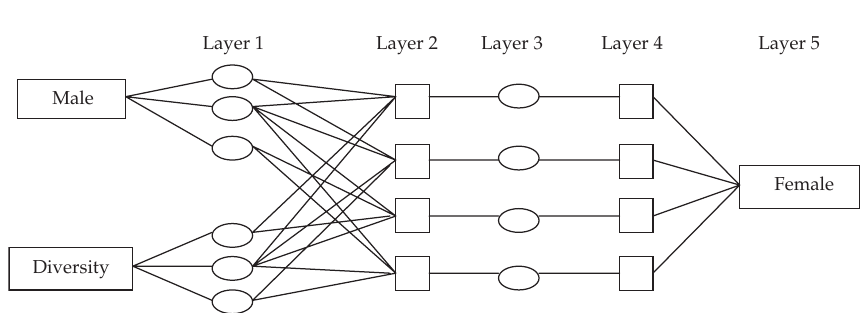
Figure 6: Adaptive neurofuzzy inference systems genetic algorithm (cid:2) ANFISGA (cid:3) .